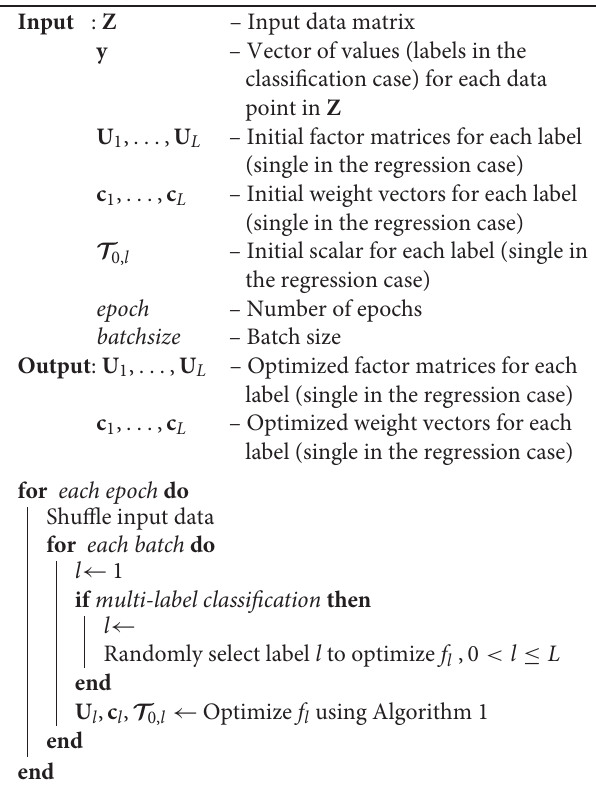
Algorithm 2: Batched GN algorithm using dogleg trust- region for regression and classification for the type II